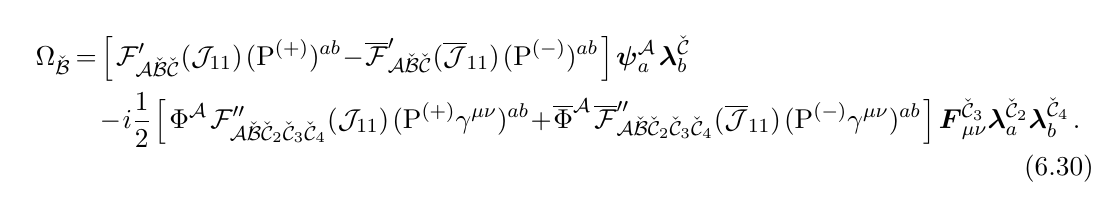
Table 5 . The summary of on-shell component fields in the CS+VS+nVS-B model.